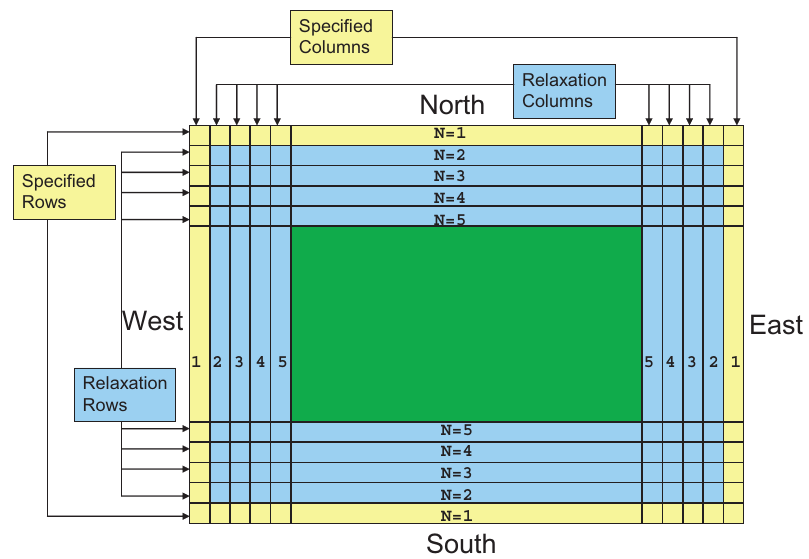
Figure 6.1: Specified and relaxation zones for a grid with a single specified row and column, and four rows and columns for the relaxation zone. These are typical values used for a specified lateral boundary condition for a real-data